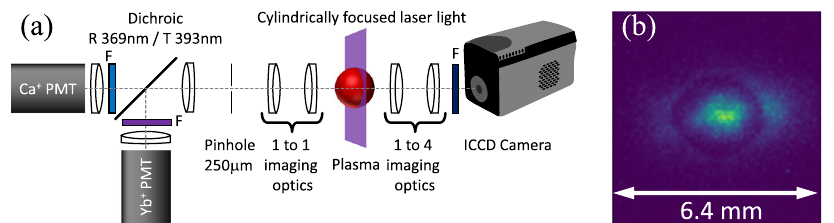
Fig. 7 Experimental details for fl uorescence detection. a Schematic diagram of the optical system used for fl uorescence detection. The plasma is illuminated by cylindrically focused laser light. Laser-induced fl uorescence is collected using an f /2 1:1 imaging system. For PMT measurements the plasma is imaged onto a ϕ = 250 μ m aperture, enabling measurements of the central portion of the plasma. Spectral fi lters in front of the PMTs allow simultaneous measurements of fl uorescence from both Ca + and Yb + ions. A spectral fi lter is also used before the ICCD camera. b Typical Ca + fl uorescence ICCD camera image, integrated over probe laser frequency, when Yb + ions are present after a time-evolution of 5 μ s. Camera measurements give spatial information at a particular time after